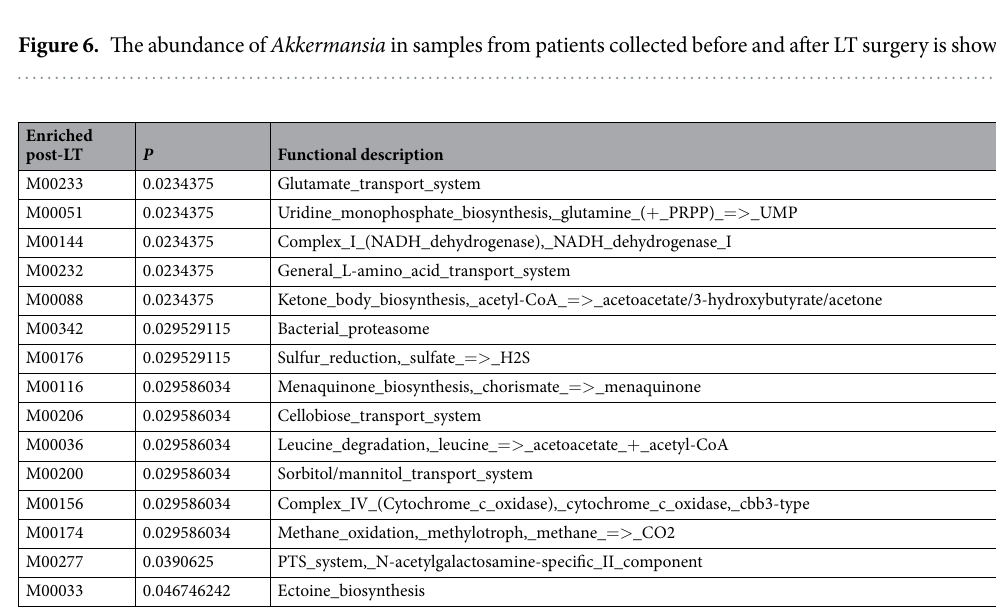
Table 3. Modules enriched in post-LT samples compared with pre-LT